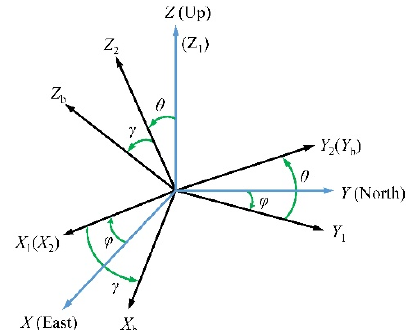
Figure 3. Orientation relationship between the carrier coordinate system and the geographic coordinate system.